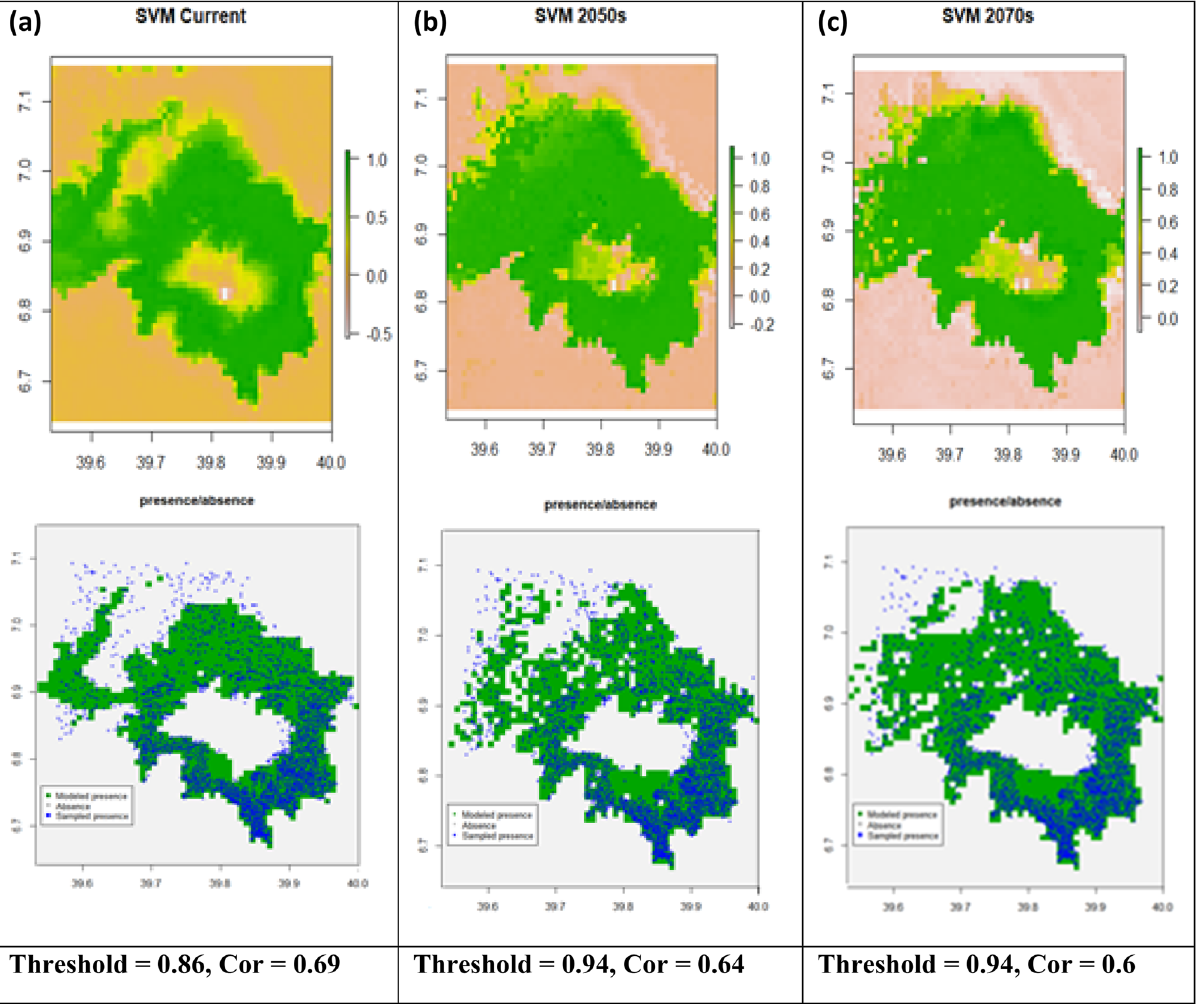
Figure 8. Support Vector Machine’s (SVM’s) prediction maps of probability of Erica occurrence for current, future 2050s and future 2070s, and their respective presence/absence maps compared with sampled presence sampling points. A gray area represents absolute absence (unsuitable habitat), green indicates modeled presence (suitable habitat), while blue circles represent sampled presence